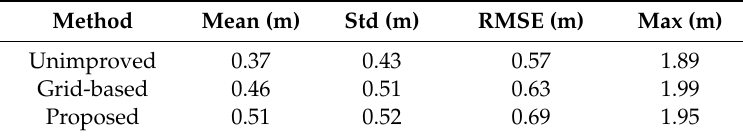
Table 1. Errors between all true road segment lane trajectories in the experimental area and the lane trajectories generated by the unimproved, grid-based, and proposed algorithms.